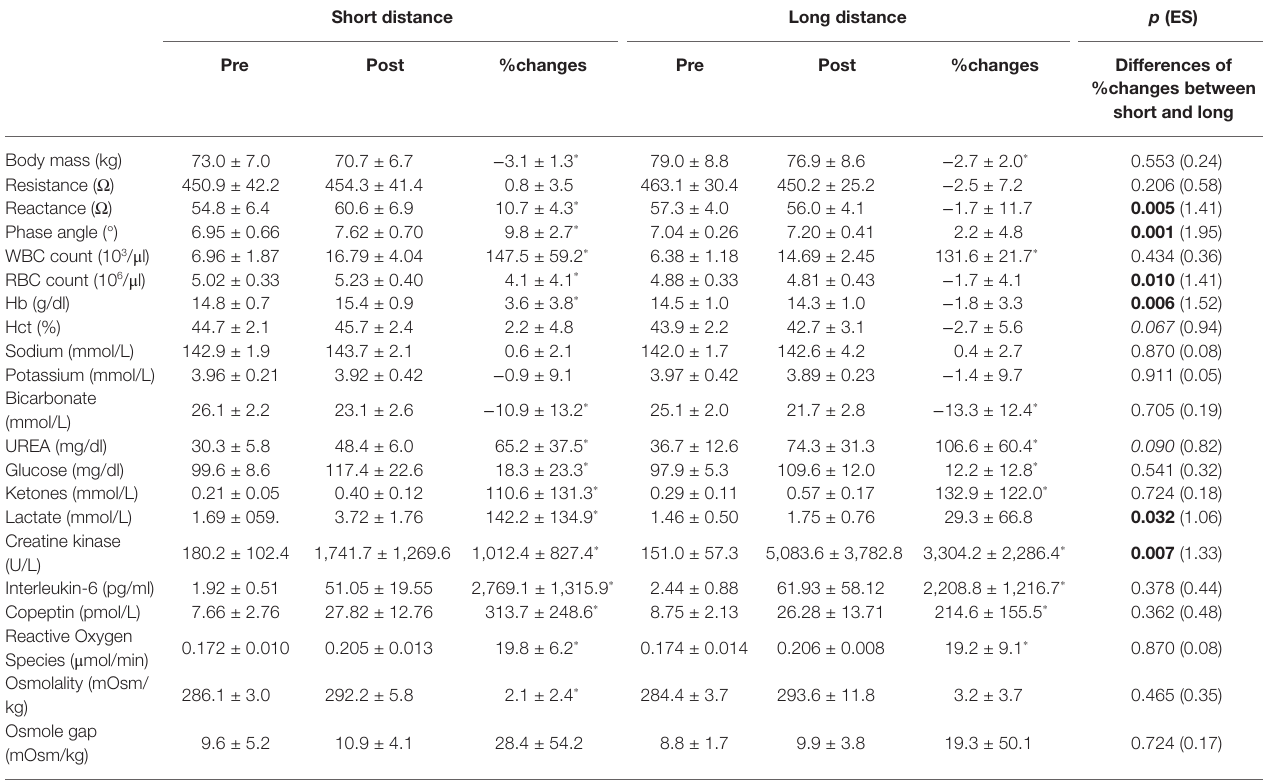
TABLE 2 | Changes in measured variables of the finishers during two ultra-endurance mountain races of different distances: 69 km, 4,260 m elevation-gain vs. 121 km, 7,554 m elevation-gain ( n = 11 and n = 7 for the short and the long distance, respectively). Short distance Long